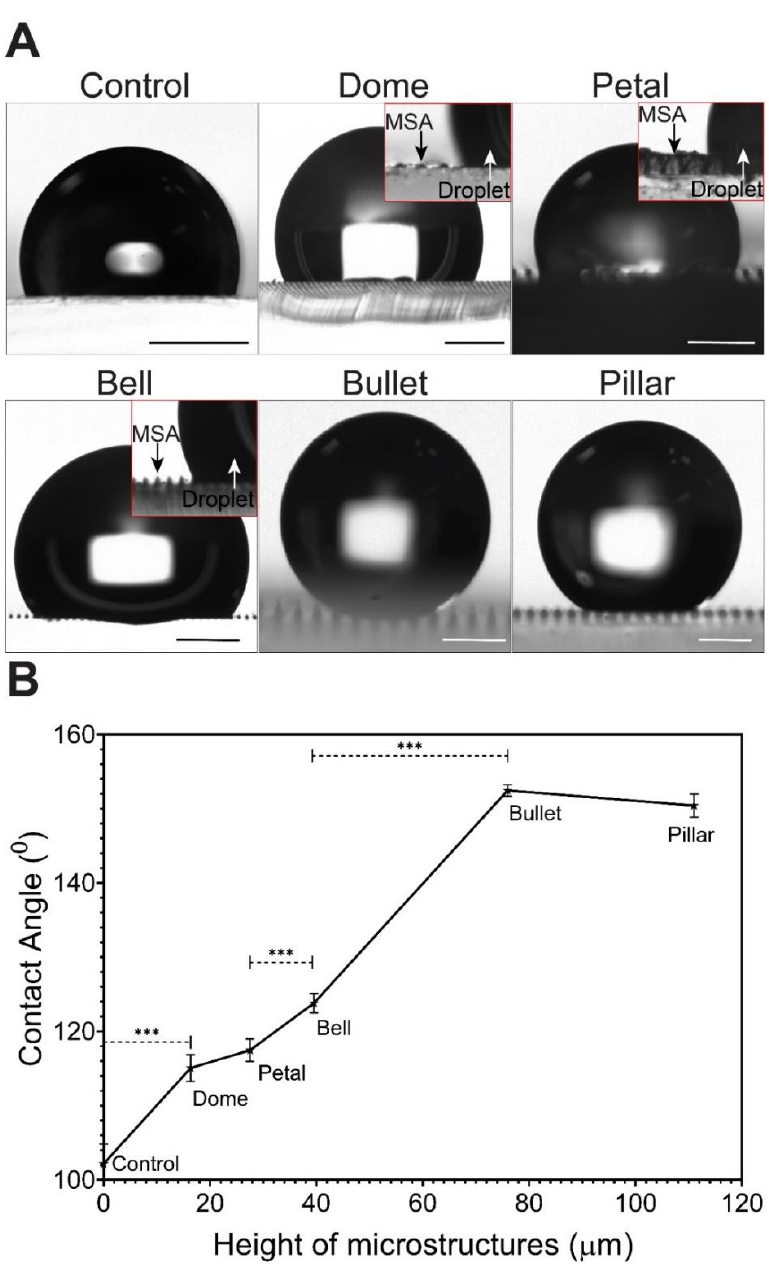
Figure 3. Contact Angle Measurement. ( A ) Microscopic images of the water droplet interaction with the MSAs. Dome, Petal, and Bell showed the Wenzel state (completely wetted surface), while Bullet and Pillar exhibited the Cassie–Baxter state (non-wetted surface), as seen in the lotus e ff ect. Wenzel state of Dome, Petal, and Bell MSAs were shown in the inset images. ( B ) Contact angle values as a function to microstructure height. Bullet and Pillar show superhydrophobic properties (contact angle above ~150 ◦ ), whereas other samples show higher hydrophobic properties than the control. The contact angle values are linearly proportional to the height (R 2 = 0.98), with all samples but Pillar. R 2 = 0.92 if including Pillar. Scale bar: ( A ) 1 mm; Bullet and Pillar: 0.5 mm. Error bars: ( B ) STDEV.